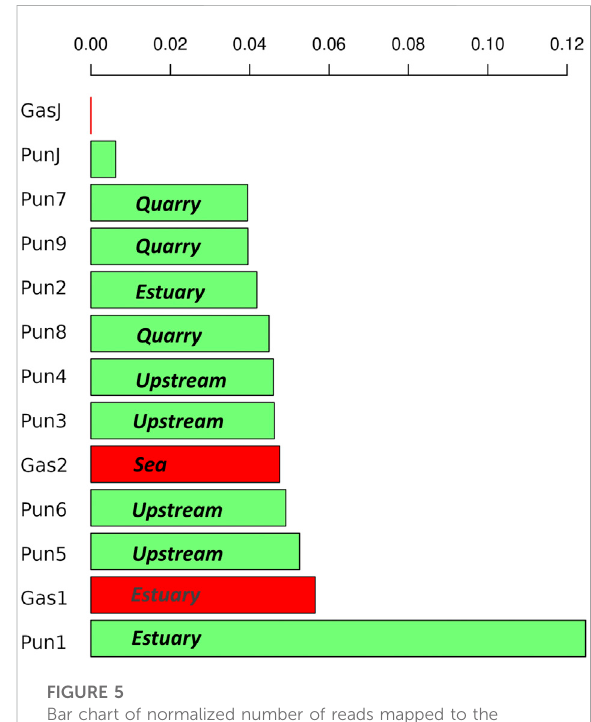
FIGURE 5 Bar chart of normalized number of reads mapped to the “ alien ” genome. Three-spined stickleback specimens marked in red; nine-spined stickleback specimens marked in green. White Sea stickleback population marked as quarry, upstream, estuary, and sea, according to the sampling